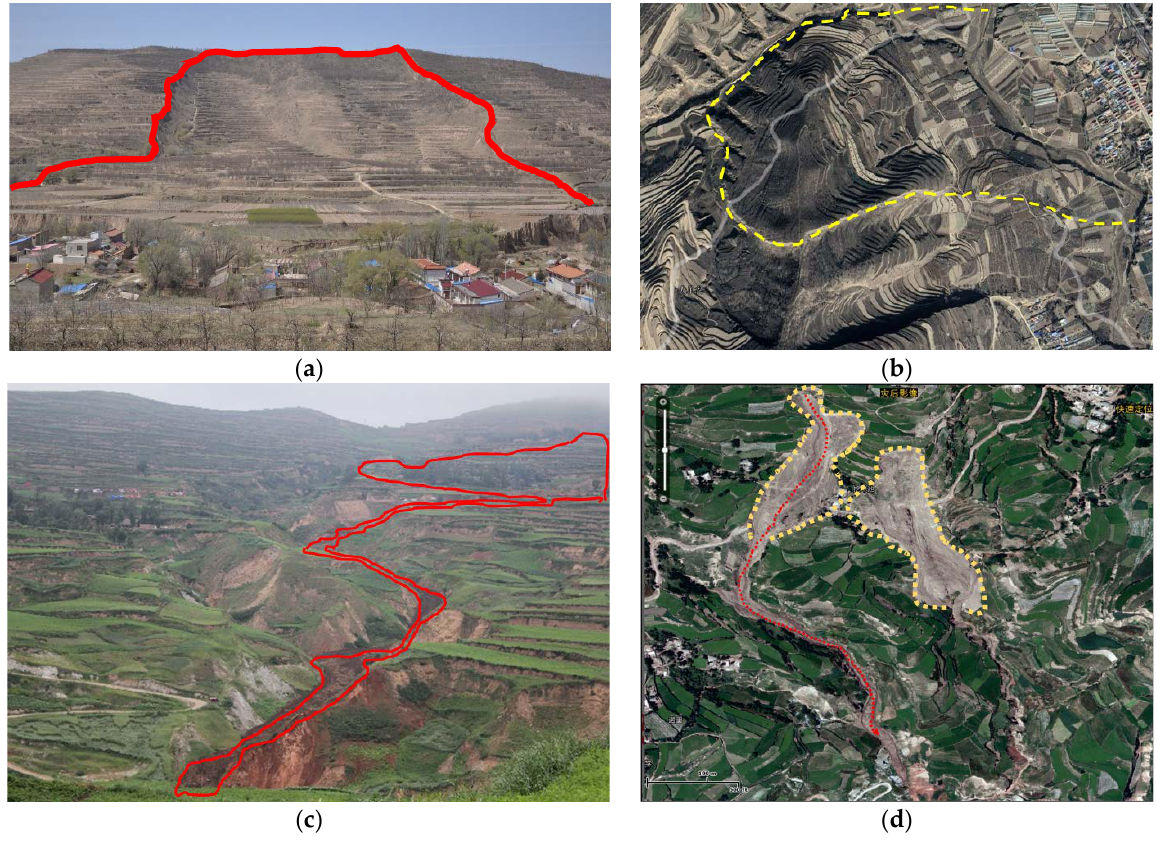
Figure 1. Earthquake-induced geological disasters in the Loess Plateau: ( a ) the Sunjiagou landslide triggered by the Haiyuan earthquake in 1920, ( b ) satellite imagery of the Sunjiagou landslide and the surrounding areas from Google Earth, ( c ) the Yongguang landslide and mudflow triggered by the Minxian-Zhangxian earthquake in 2013, and ( d ) satellite imagery of the Yongguang landslide and slide path of the mudflow. Note the red line in ( a ) and ( c ), and the yellow line in ( b ) and ( d ) are the boundary of the landslides, the red dotted line in ( d ) is the slide path of the mudflow.